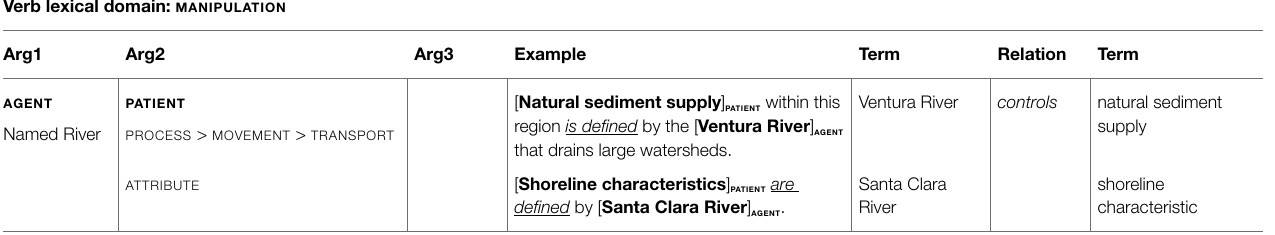
TABLE 10 | Results from the semantic annotations for the lexical domain of manipulation . Verb lexical domain: